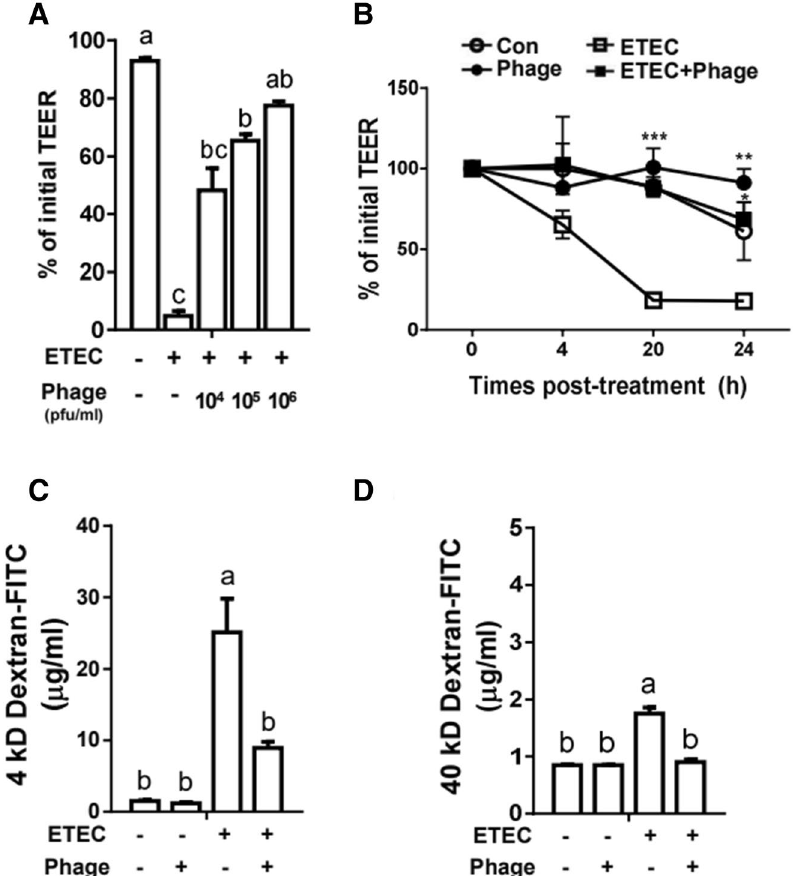
Figure 1. Phage EK99P-1 restored intestinal permeability in porcine intestinal epithelial cell line IPEC-J2 infected with enterotoxigenic Escherichia coli (ETEC K99). Differentiated IPEC-J2 were treated with ETEC K99 (1 × 10 7 cfu/mL) and phage EK99P-1 (1 × 10 6 pfu/mL) for 24 h. ( A ) Transepithelial electrical resistance (TEER) was measured in epithelial volt/ohm after 24 h of infection and ( B ) at the indicated time points. Each datum represents a percentage of initial TEER (n = 3). * P <0.05; ** P < 0.01; *** P < 0.001. ( C,D ) Permeability